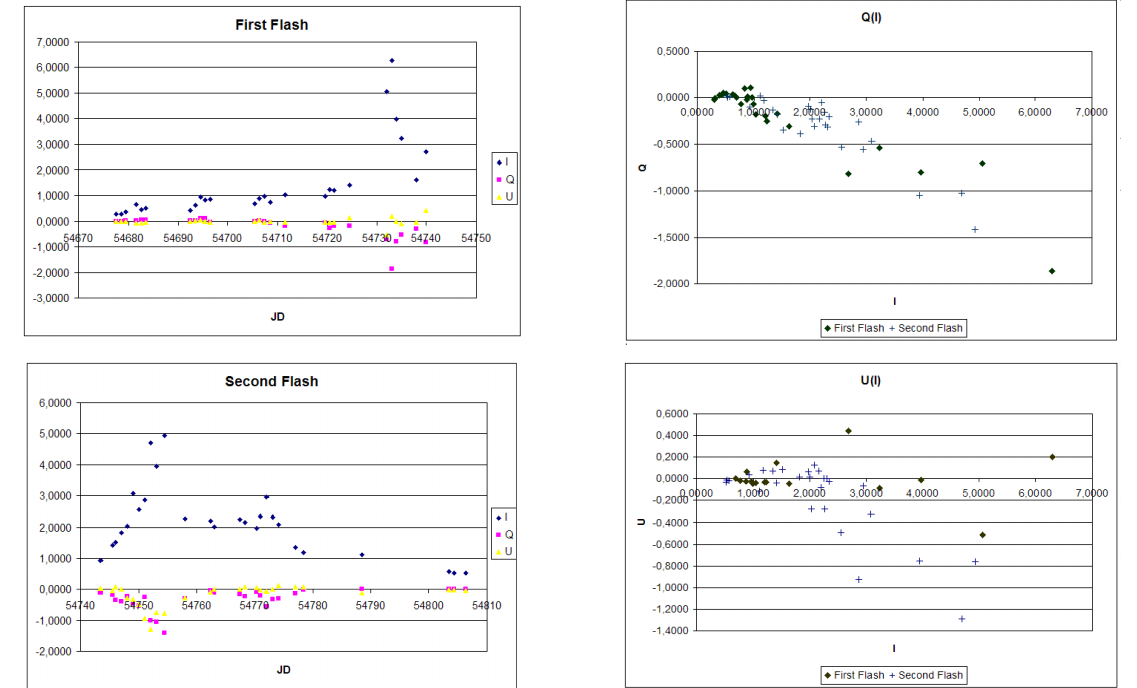
Figure 7. Absolute Stokes parameters behaviour ( left ) and Q ( I ) and U ( I ) ( right ) at the first period.